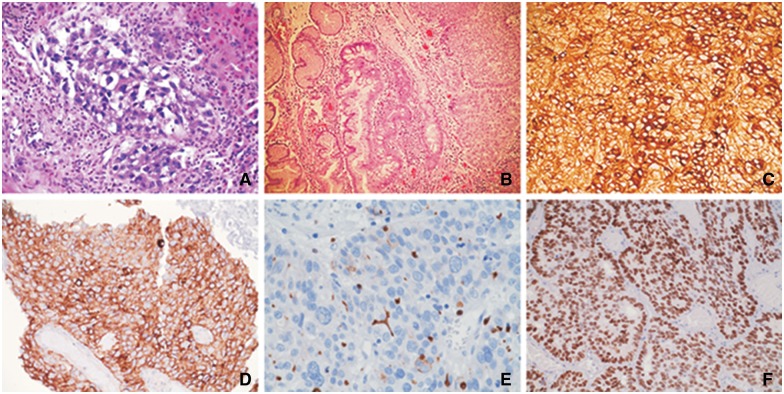
Histopathology and immunohistochemistry studies. (A) Liver specimens show polygonal tumor cells arranged mainly in a trabecular pattern and areas of glandular formations with abundant eosinophilic cytoplasm and round nuclei (hematoxylin and eosin stain, original magnification × 100). (B) Esophageal specimens show neoplastic hepatocyte-like cells arranged in nests and trabecular pattern with intervening fibrovascular stroma. Adjacent intestinal metaplasia (Barrett’s esophagus) is evident (hematoxylin and eosin stain, original magnification × 100). (C) Neoplastic cells from esophageal tumor were positive for alpha-fetoprotein staining (original magnification × 200). (D) Esophageal specimens show positive staining for glypican-3 (original magnification × 200). (E) Carcinoembryonic antigen (polyclonal) staining of esophageal specimens, although positive, did not show the definite canalicular staining pattern of hepatocellular carcinoma (original magnification × 400). (F) Esophageal specimens were positive for SALL4 staining (original magnification × 200).